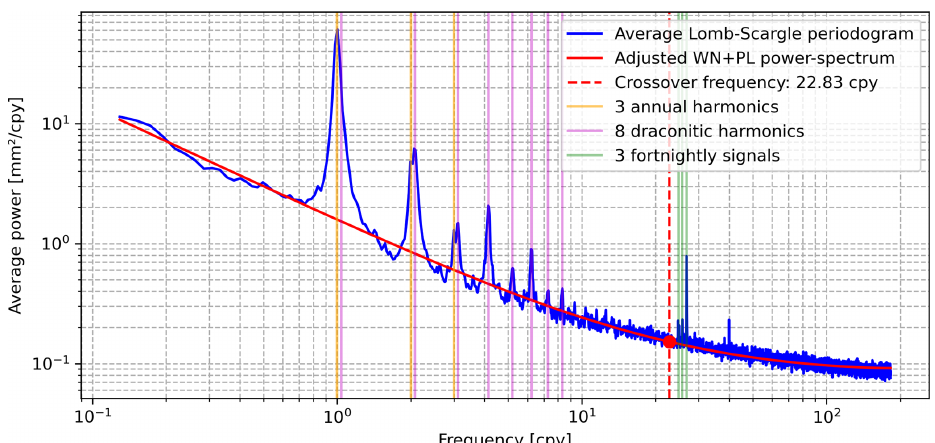
Figure 5. Average Lomb–Scargle periodogram for the ULR-repro3 detrended vertical position time series corrected for NTAL displacements (frequency unit is cycles per year, denoted as